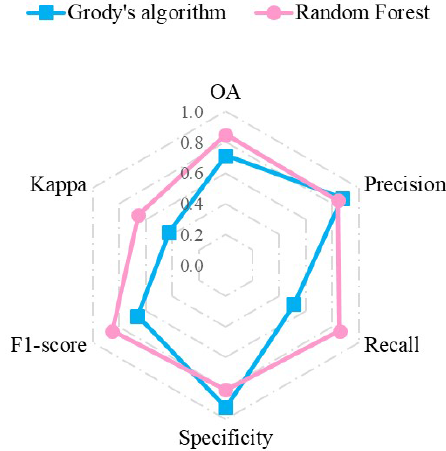
Figure 12. The accuracy indicators (OA, precision, recall, speci- ficity, F1 score, kappa) of snow cover detection from two algorithm (Grody’s algorithm; random